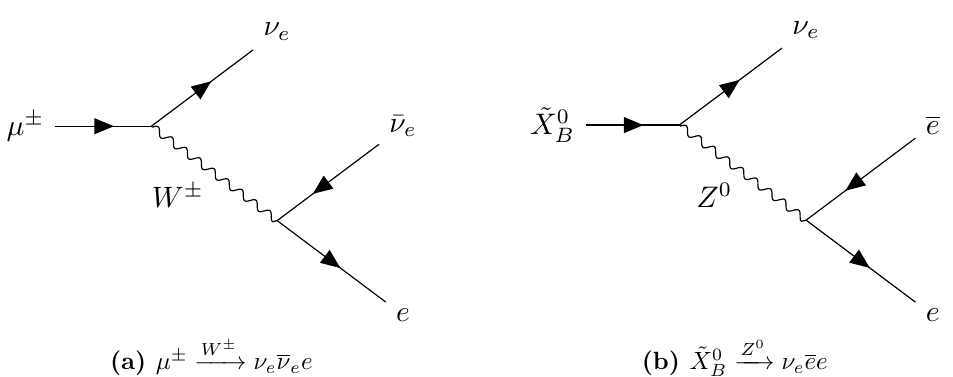
Figure 10. The Feynman diagram of a (cid:22) (cid:6) lepton decay (left) has a similar structure to that of a Bino LSP decay (right). We use this similarity to compute the decay rates of a Bino LSP via o(cid:11)-shell bosons, using the Madgraph